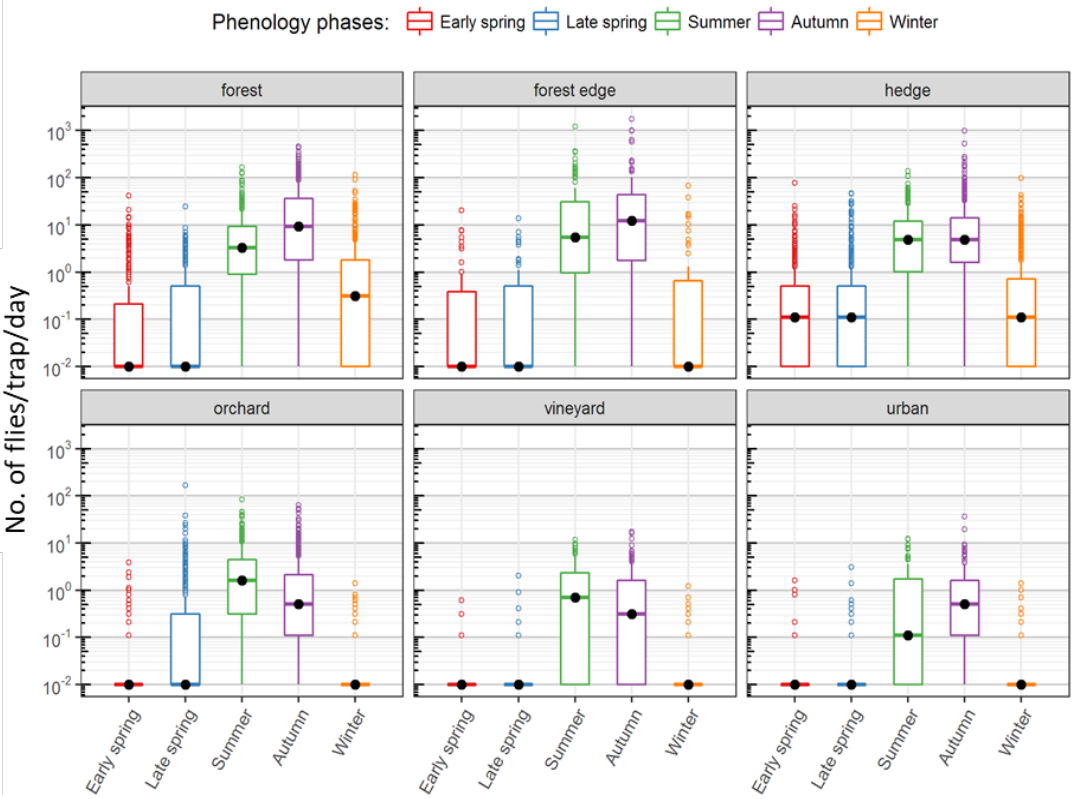
Figure 4. Box plots of daily captures in each sampled habitat type grouped by season. The median values represented by the bold black dots in each box plot highlight the variations in the seasonal dynamics of the captures in each sampled habitat type. The box represents the inter-quartile range (IQR) and the band inside the median. The whiskers represent data that are within 1.5 IQR below or above the first and the third quartiles, respectively. The outliers are represented by dots beyond the whiskers. Note: the Y-axis is log-scaled (captures/day/trap + 0.01).